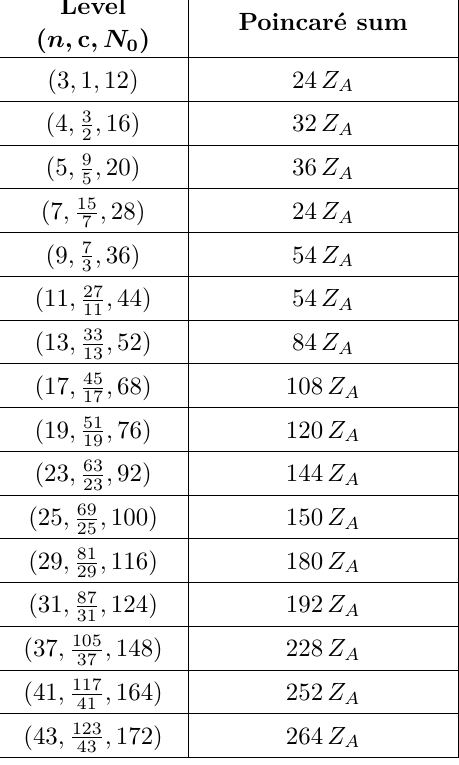
Table 1. Poincaré sums for SU(2) k WZW models with unique modular